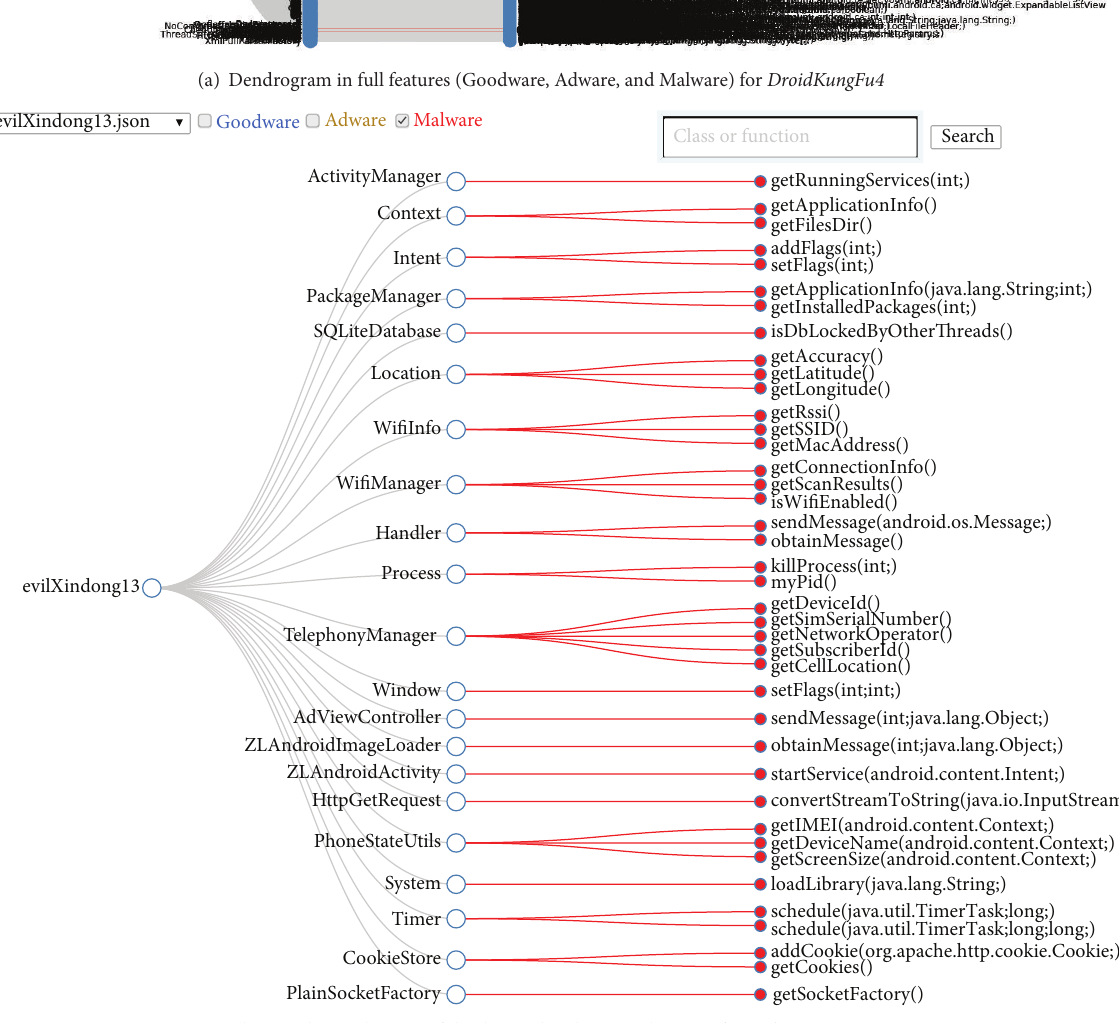
Figure 8: Dendrograms of the tested application. (a) Graph of the DroidKungFu4 in full features, and (b) graph of the malicious functions invoked by DroidKungFu4 . The full package name of DroidKungFu4 is